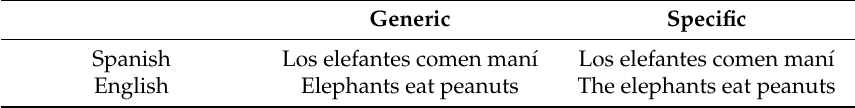
Table 1. Noun phrase (NP) types and mapping of generic and specific in Spanish and